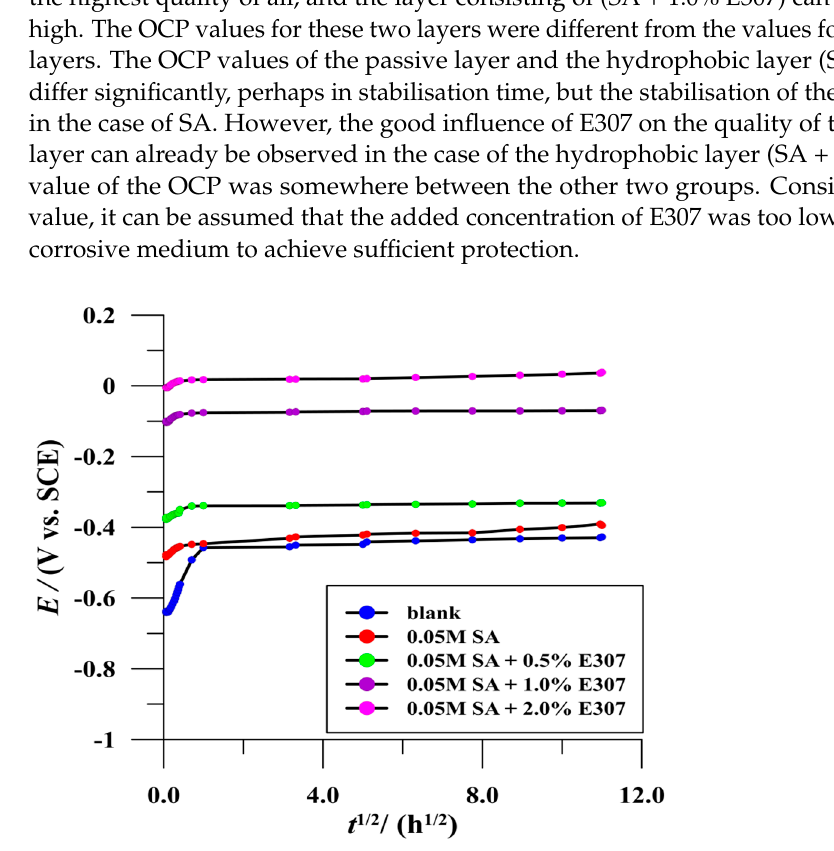
Figure 3. OCP vs. time curves (t ½/h½) for SS type AISI 410S for bare and modified surfaces in a simulated solution of acid rain with pH = 3 at 25 °C after 1, 10, 25, and 120 h of immersion.